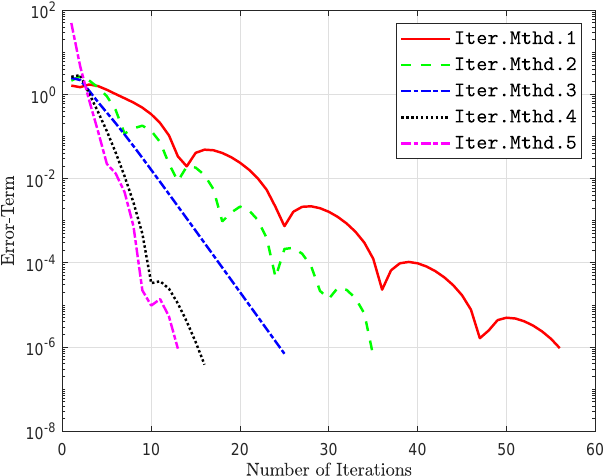
Figure 13. All techniques are computationally examined while s 0 = ( − 1,6,3, − 4,4 ) T .